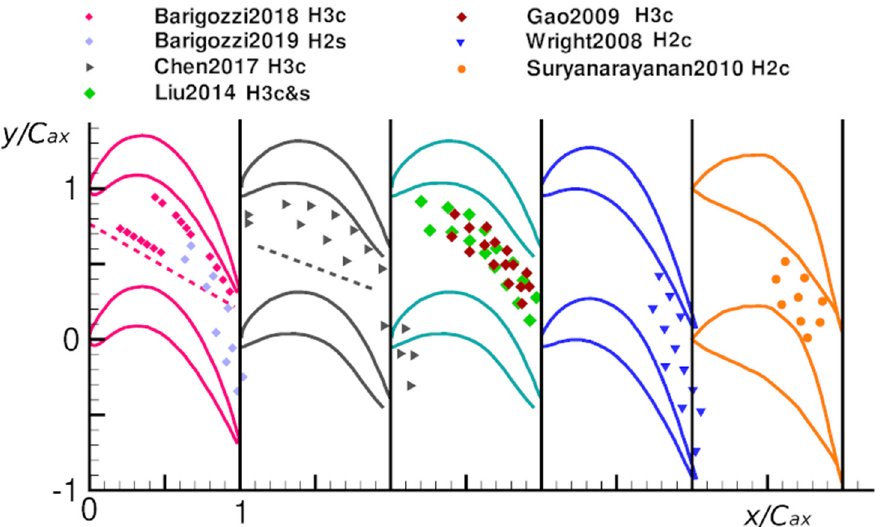
Figure 3. Discrete cooling hole locations in the blade passage. Table 2. Typical hole geometrical